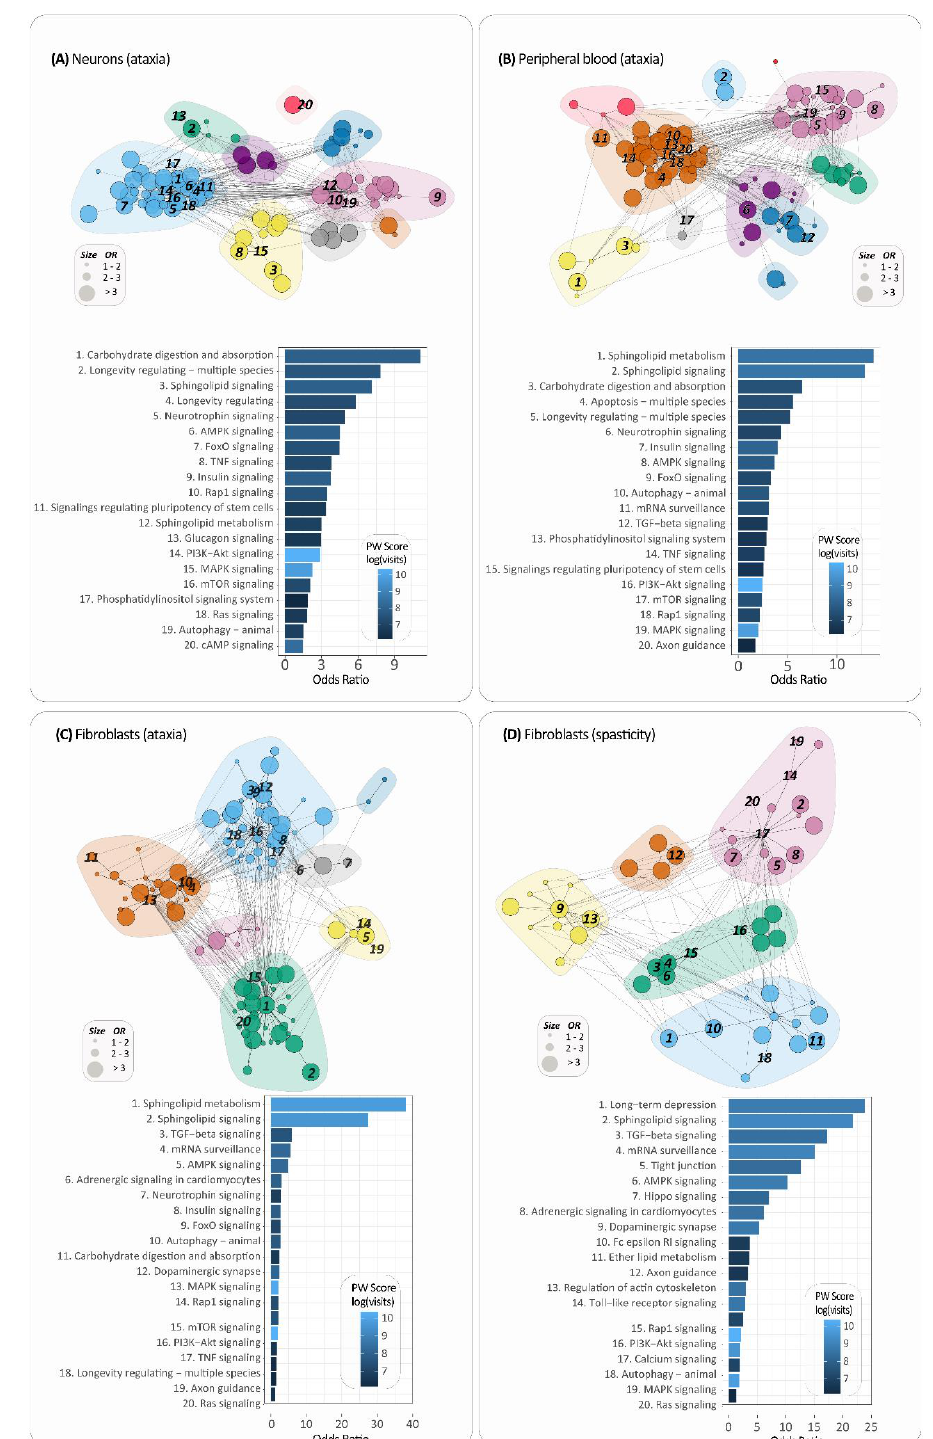
Figure 3. Pathway-to-pathway networks were generated for the highlighted clusters of pathways provided by PathWalks analysis for ( A ) neuronal “ataxia”, ( B ) peripheral blood “ataxia”, ( C ) fibroblast “ataxia” and ( D ) fibroblast “spasticity” datasets. A bar graph was also constructed for each network to show the pathways with OR > 1 as the most involved pathways in